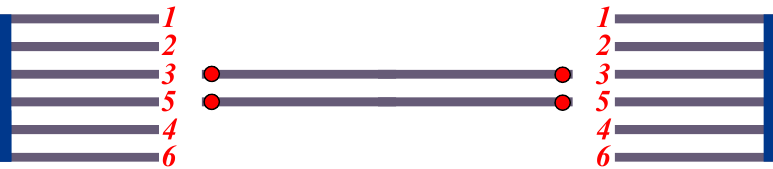
Figure 8: Two one-sided hexons in the MZM labeling configuration 〈 1,2,3,5,4,6 〉 . hexons for the MZM labeling configuration 〈 1,2,3,5,4,6 〉 , as shown in Fig.